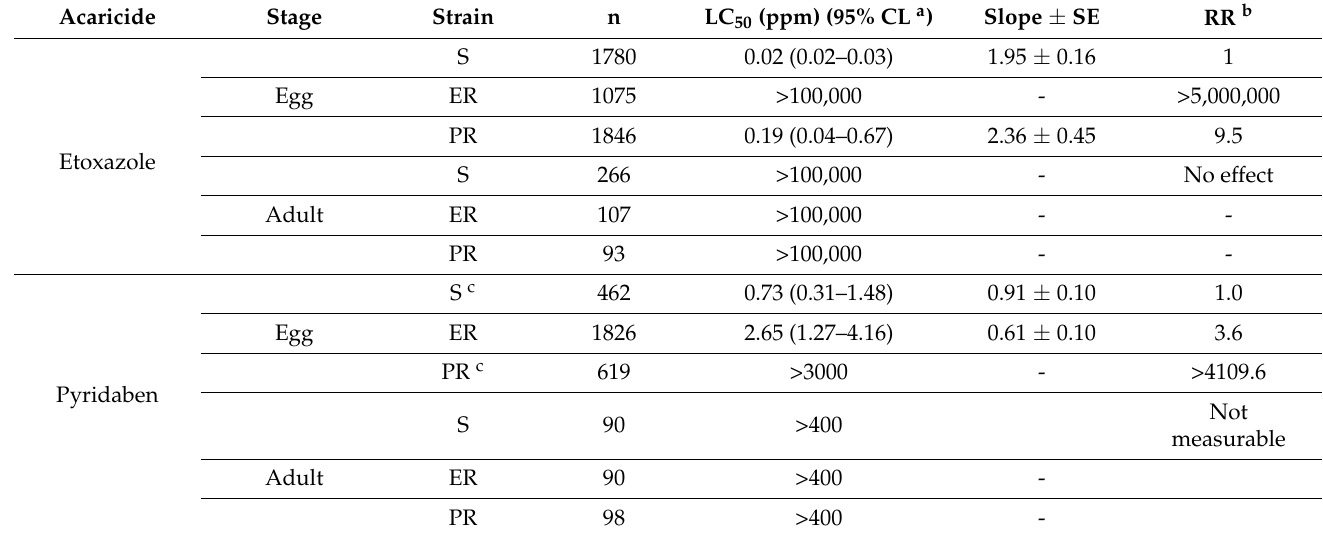
Table 3. Susceptibility to etoxazole and pyridaben in S, ER and PR strains of T. urticae